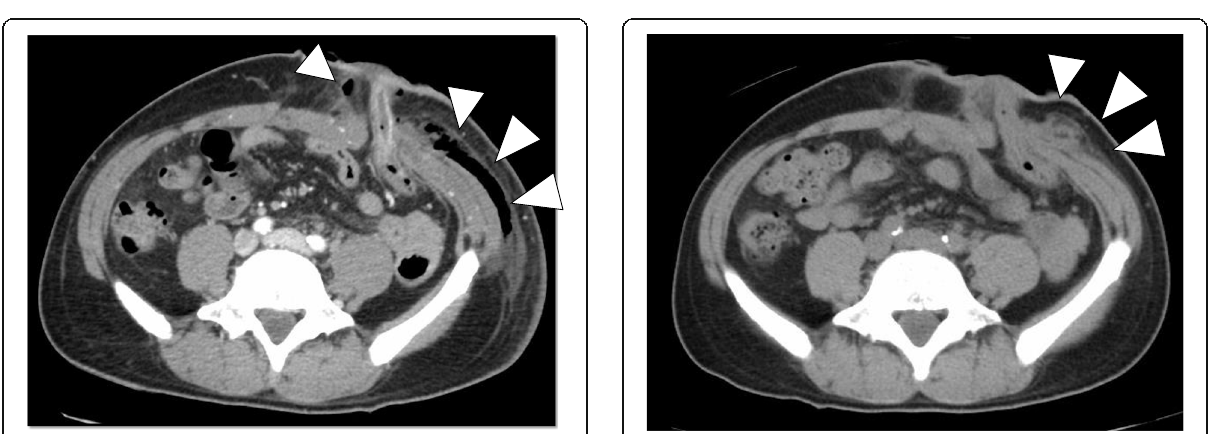
Fig. 4 Follow-up computed tomography of the abdomen after the drainage showed abscess decrease (white